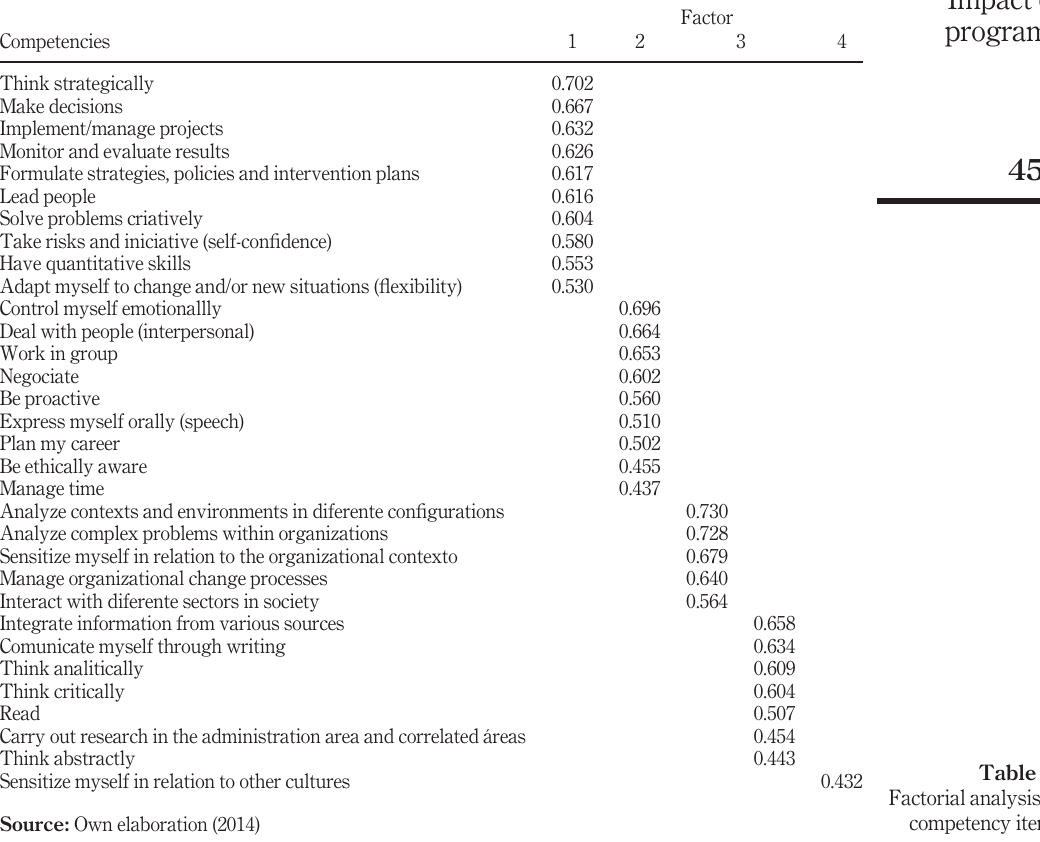
Table II. Factorial analysis